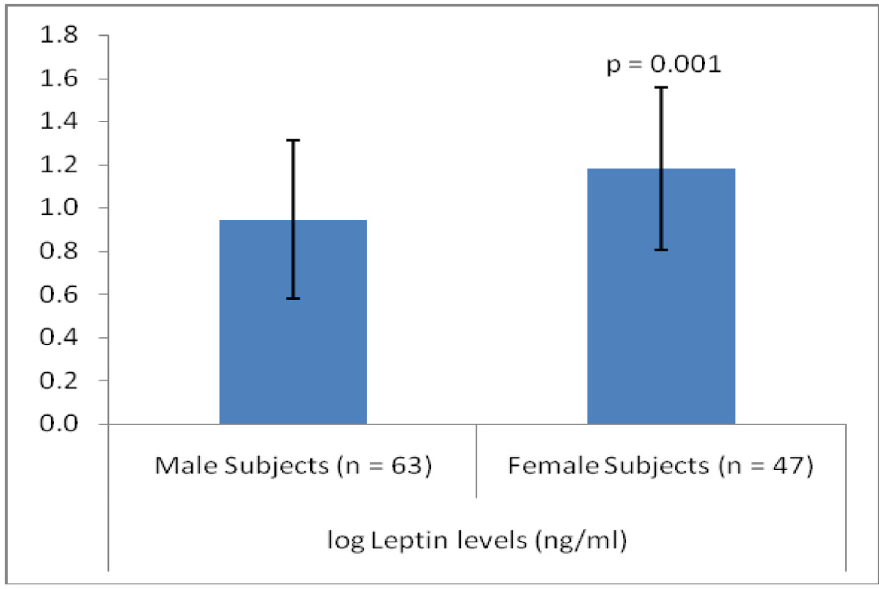
Fig 1. Circulating leptin levels in the study subjects. Log transformed serum leptin was significantly higher in female subjects compared to their male counterparts ( P = 0.001).